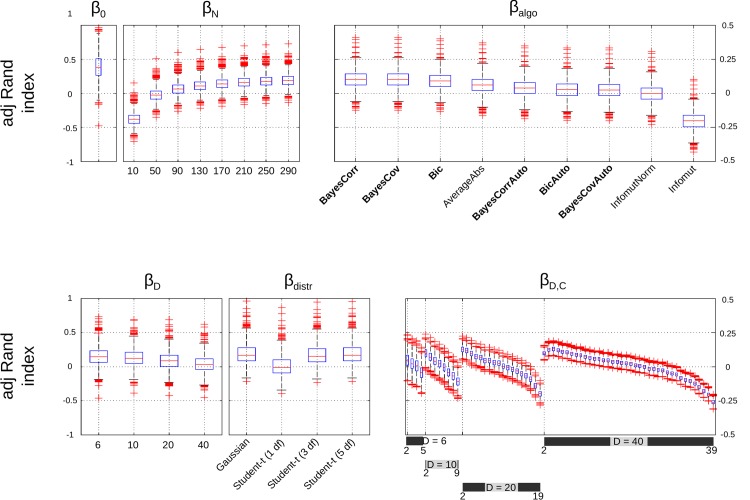
Simulation study.Result of the regression analysis. Posterior distribution for the different regression coefficients: β
0 (global effect), β
N (dataset size N), β
algo (algorithm), β
D (number of variables D), β
distr (type of distribution), and β
D, C (number of clusters) [see Eq (24)].